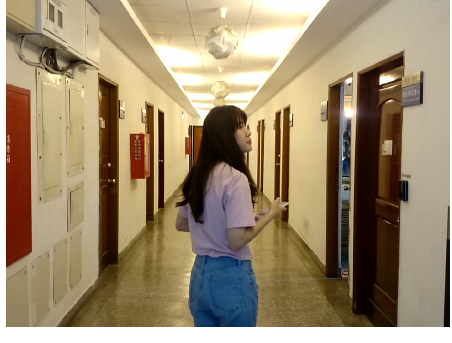
Figure 29. Second testing image. Table 4. The score for each composition method in the second testing